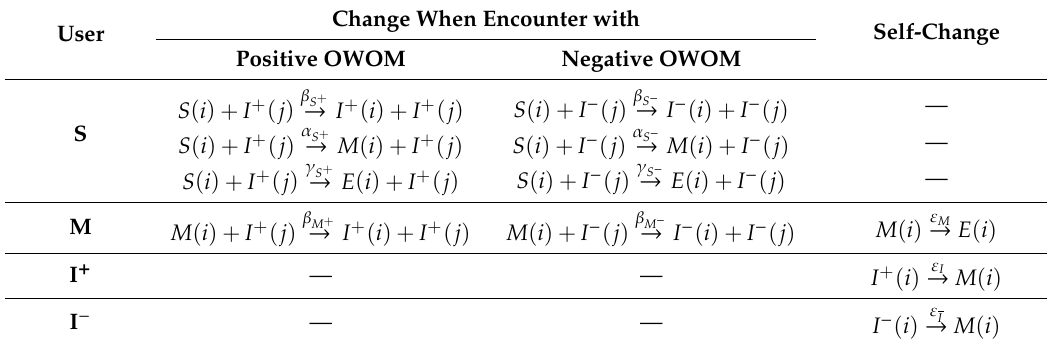
Table 1. Brand OWOM communication participates in user